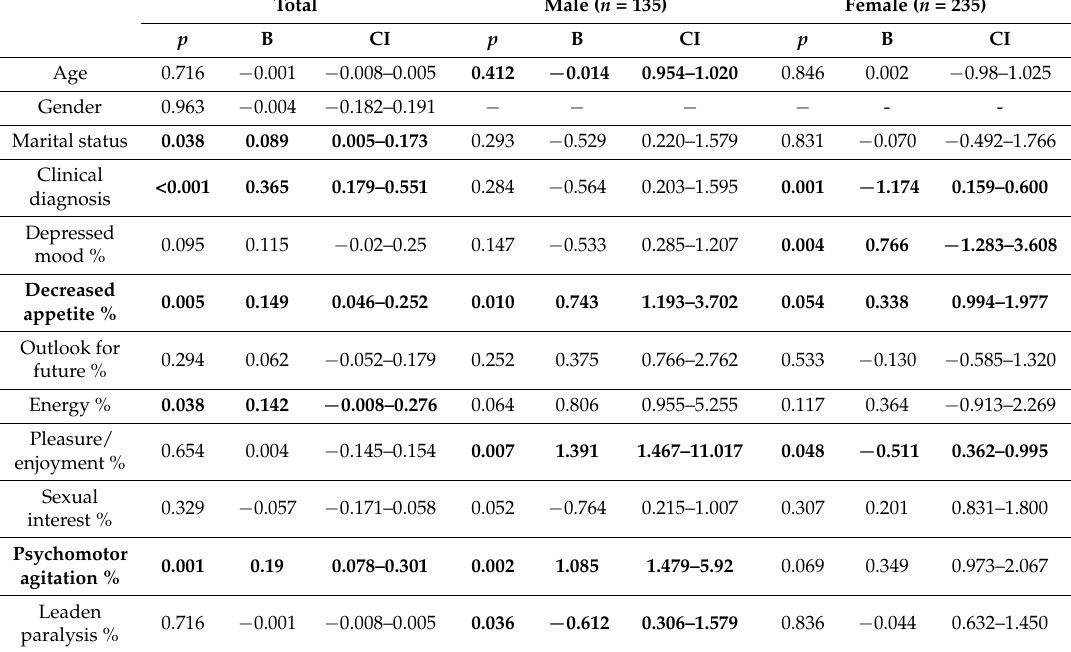
Table 5. Multivariate analysis: logistic regression, with disturbance in function due to sleep problems as the dependent binary variable, in AD and DE combined (i.e., the entire